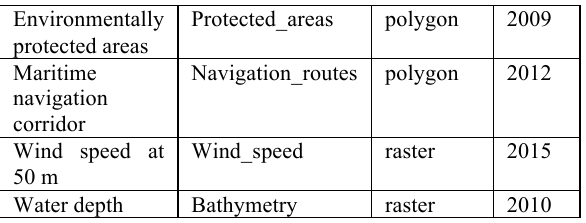
Table 3: Data sets used in the study